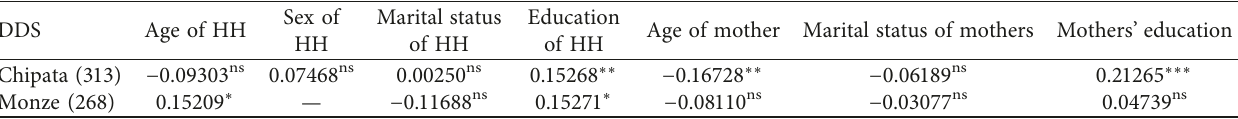
Table 8: Correlations of DDS of mothers and sociodemographic characteristics of household heads and mothers in Chipata and Monze